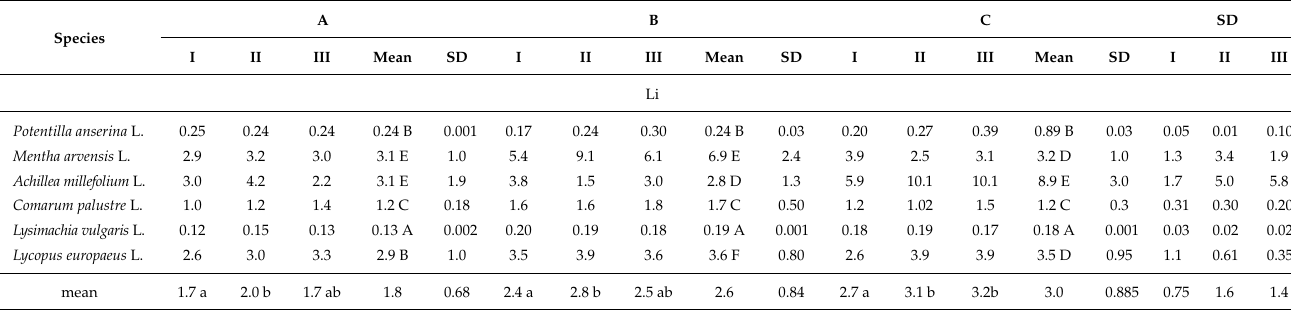
Table 2. Li concentration (mg kg − 1 ) in the biomass of some herbs.